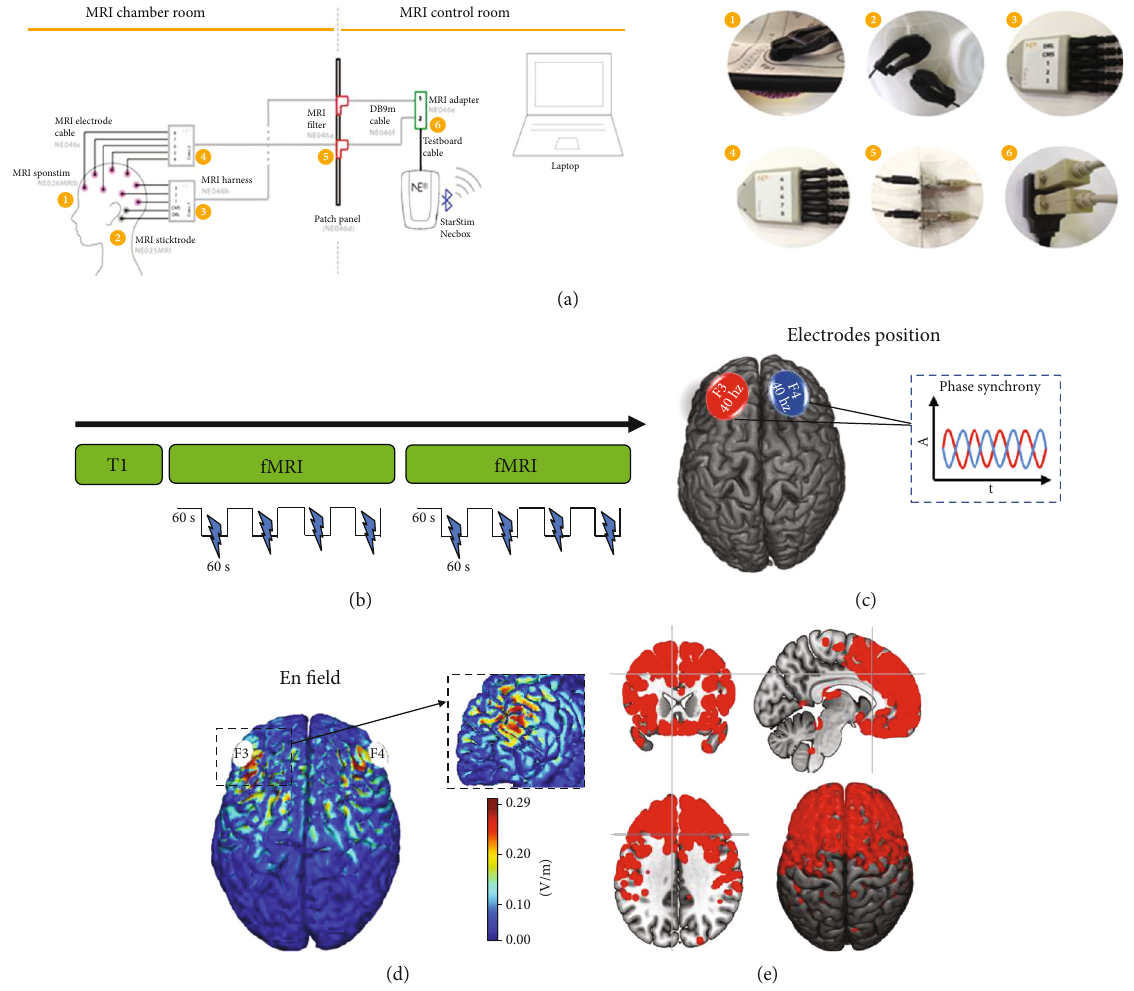
Figure 1: Experimental paradigm. (a) Schematic example of MRI-compatible tES device setup. (1) Details of electrode arranged in the cap, (2) CMS/DRL mastoid electrodes for impedance check, (3) and (4) MRI -compatible touchproof connector, (5) patch panel connection, (6) Starstim cable adaptor. (b) Overview of the tACS-fMRI experimental session. (c) Electrode positions and phase. (d) Normal electric fi eld (normE) simulated on a single-subject template Colin27. (E) En binary mask thresholded at 0.8 and used as mask for the second-level